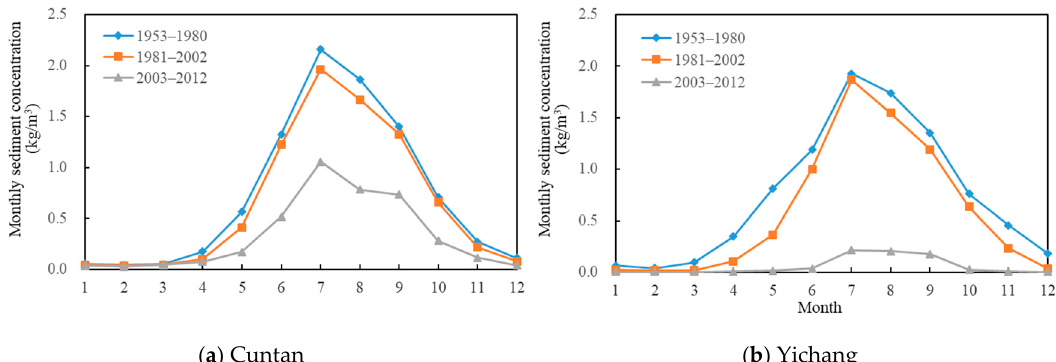
Figure 4. Impact of reservoirs on the monthly distribution of sediment concentration. Notes: the average monthly sediment concentration (kg / m 3 ) was calculated using the average monthly sediment discharge (kg / s) divided by the average monthly flow discharge (m 3 / s) according to the Code of Hydrologic Data Compilation [32].